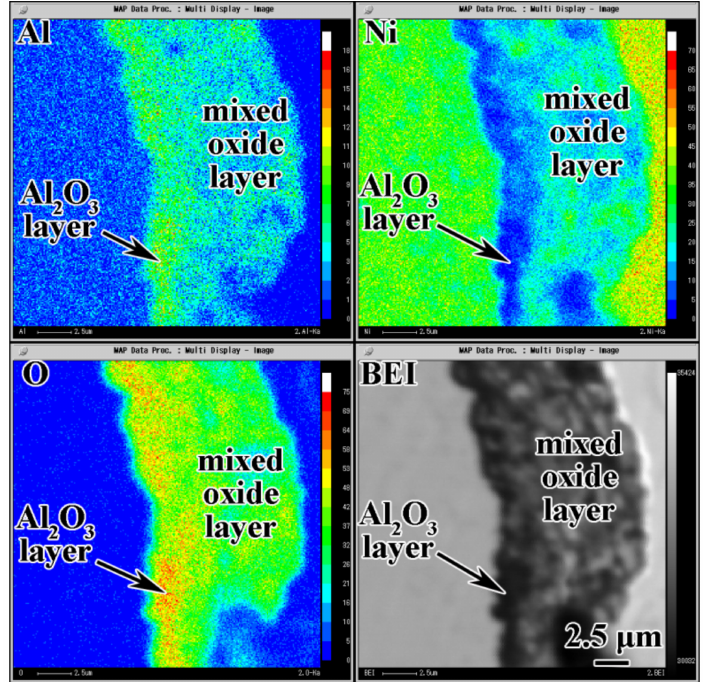
Figure 3. Cross-sectional image and element distribution maps for the scale of the preoxidised coating in the as-received